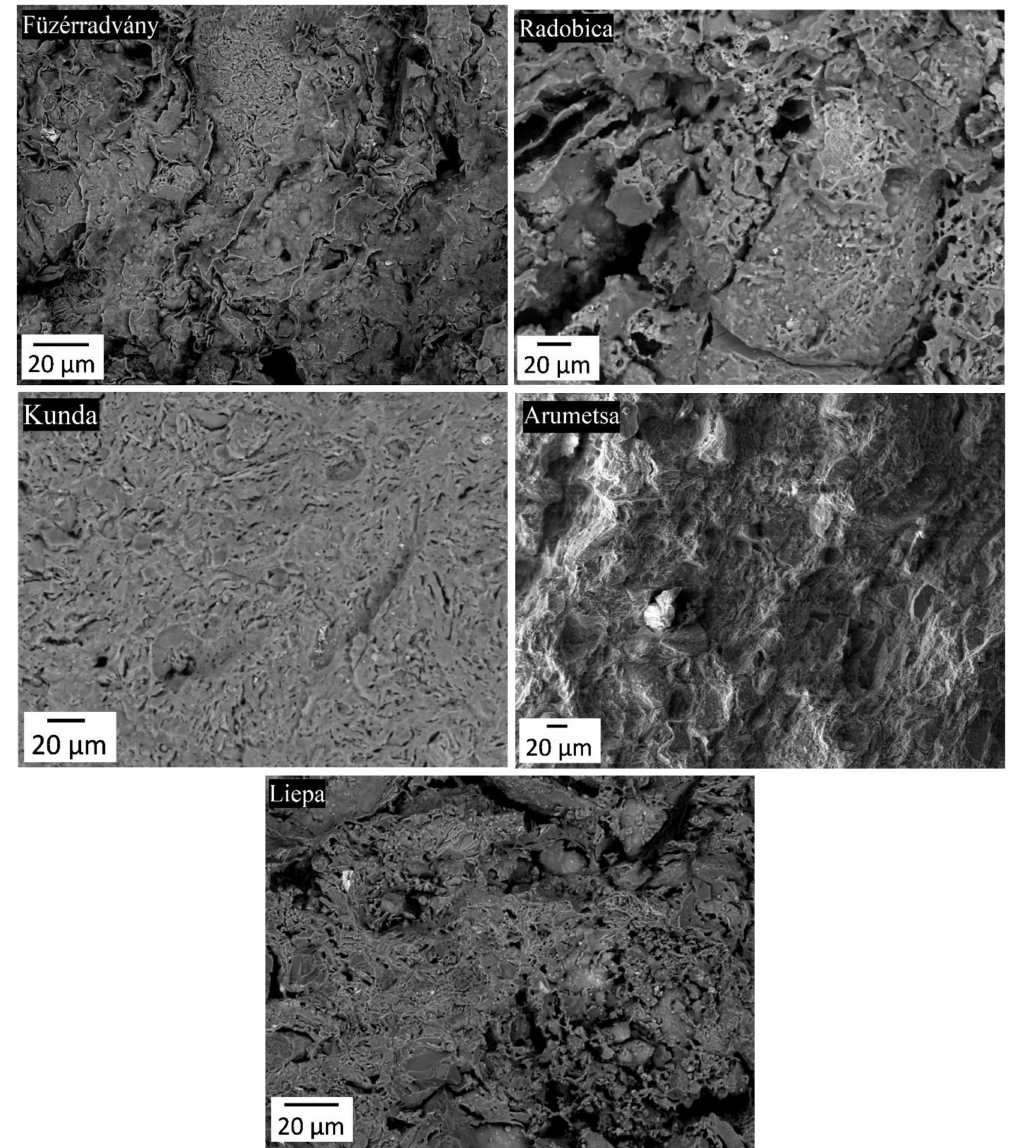
Figure 7. The SEM micrographs of fracture surfaces of experimental samples fired at 1100 ◦